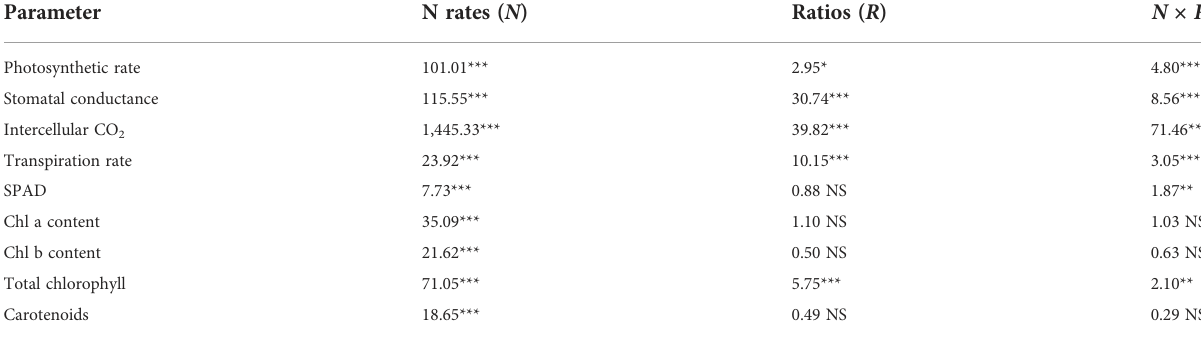
TABLE 2 Signi fi cance of the F -value from ANOVA of the various parameters of winter wheat affected by nitrogen management. Parameter N rates ( N ) Ratios ( R ) N × R